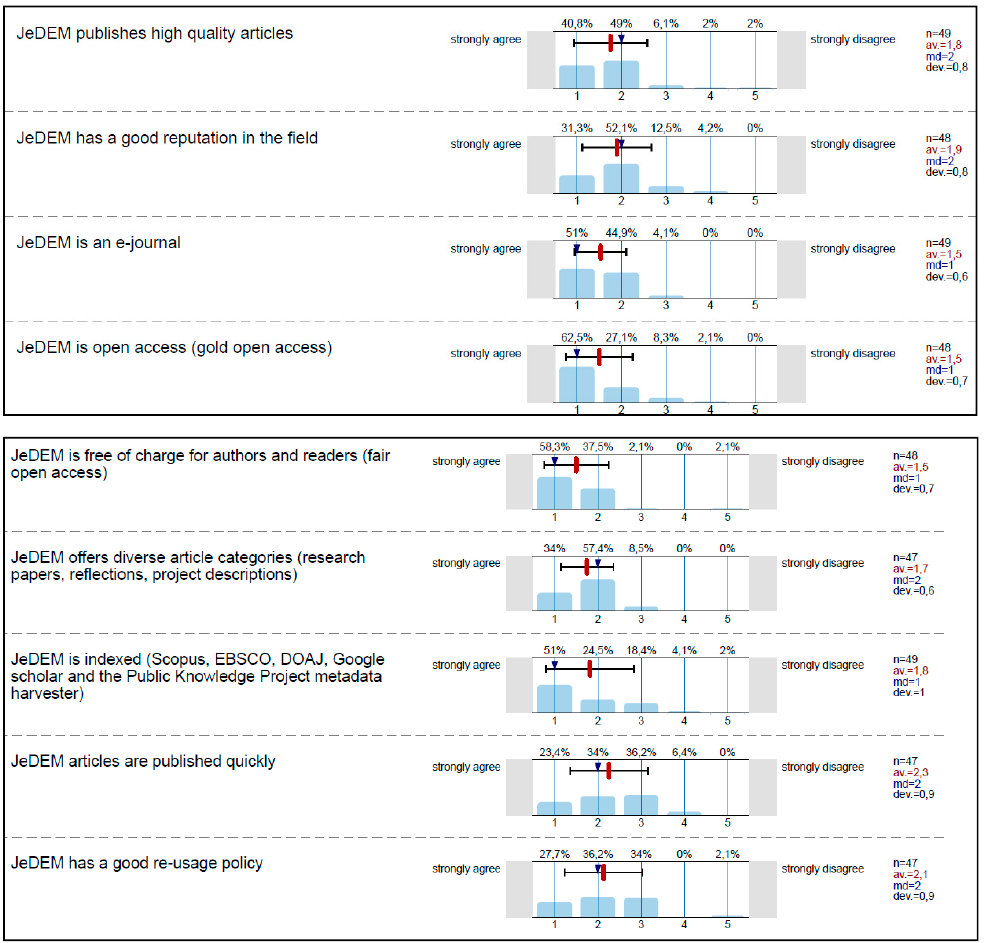
Figure 3. Results about why authors chose to publish with OA eJournal for eDemocracy and Open Government (JeDEM).